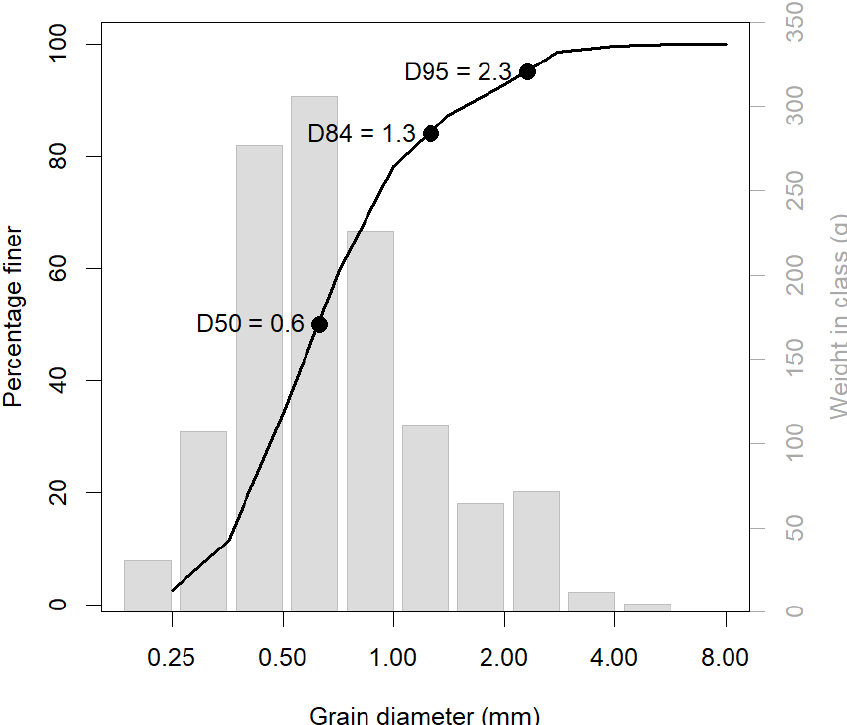
Figure 3. The grain size distribution (GSD) of our experimental sediment mixture. The cumulative distribution is on the primary y axis, and the individual class weights are on the secondary y